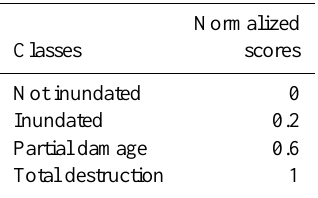
Table 2. Physical/environmental risk classes and normalized scores for